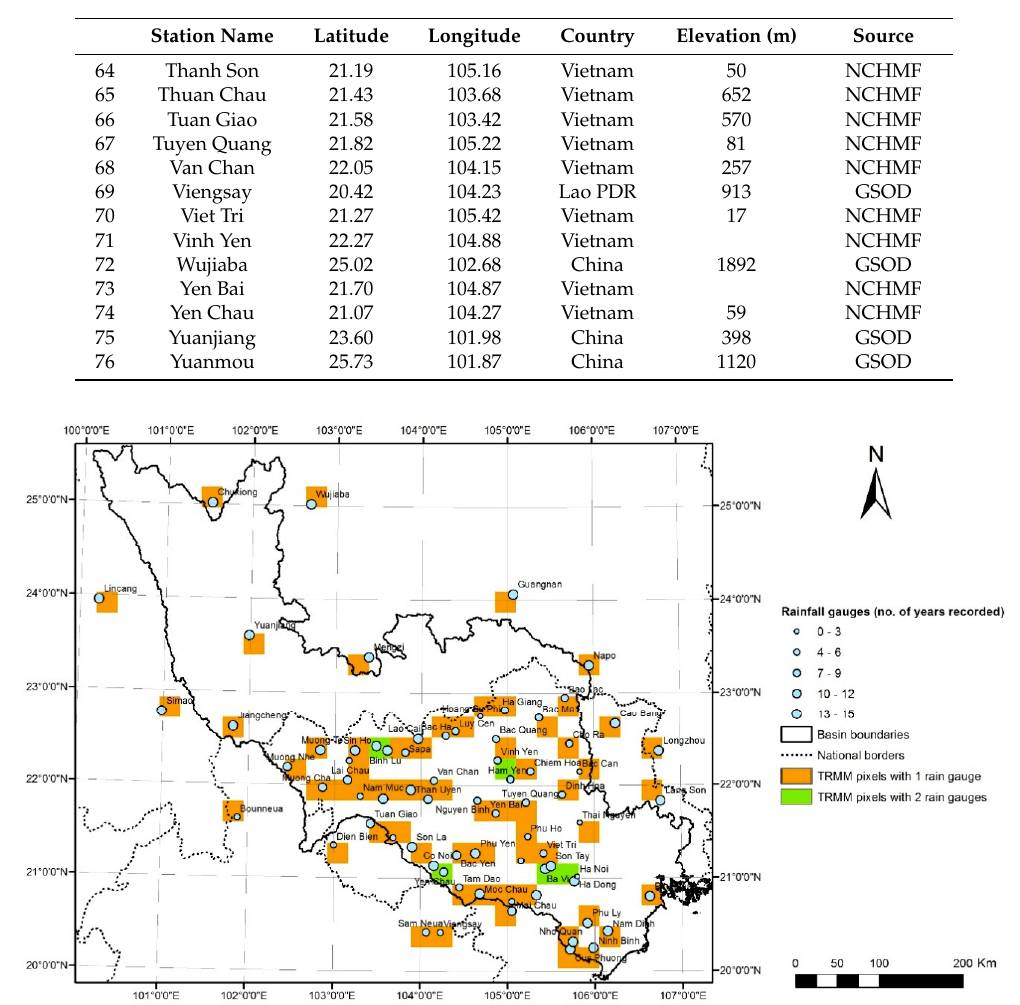
Figure A1. Spatial distribution of TRMM pixels with one ( red ) or two ( green ) rainfall gauges.